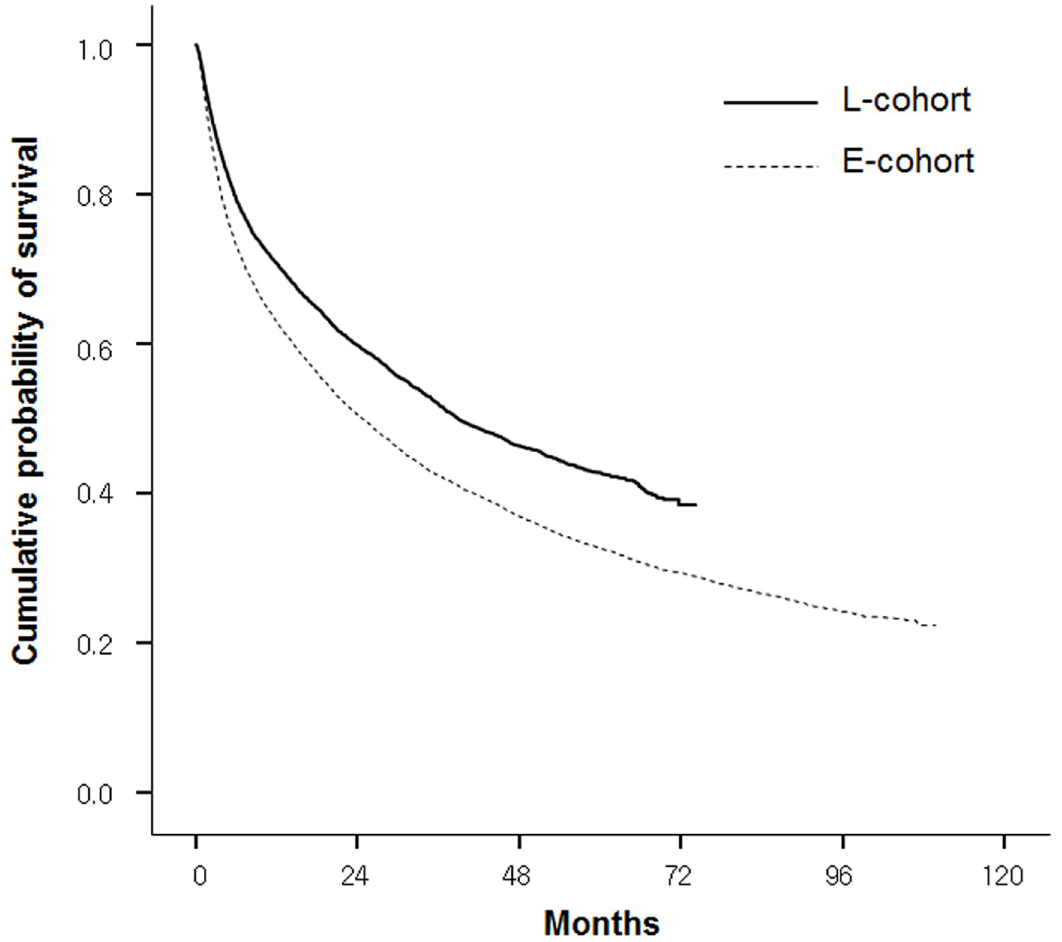
Fig 1. Kaplan-Meier analysis of overall survival between the E-Cohort and